Question: Briefly state, in one sentence, what is plotted here.
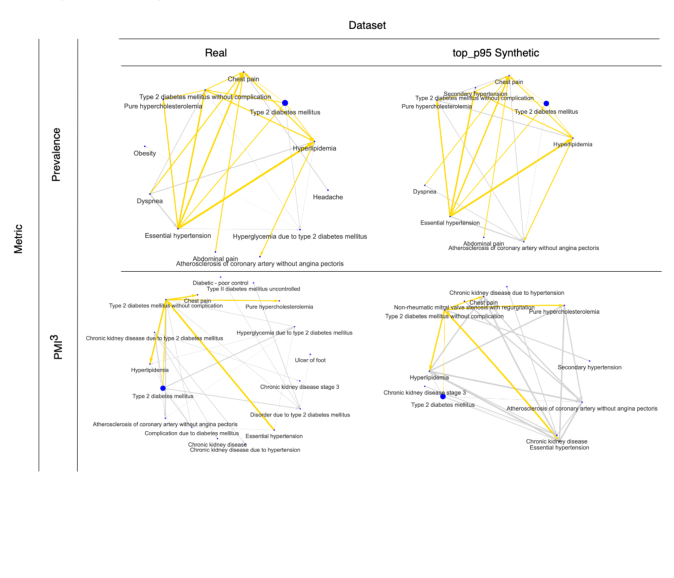
Answer: Comparison of temporal co-occurrence networks around Type 2 Diabetes Mellitus (T2DM) for real (left) and synthetic data (right). Networks were constructed with T2DM’s (large circle) top 5 co-occurring condition concepts and their own top 5 co-occurring condition concepts. The metrics Prevalence (top) and Pointwise Mutual Information-3 (PMI3) (bottom) were used to quantify co-occurrence. Gold edges indicate edges that are shared by both real and synthetic data, edge thickness indi- cates the strength of co-occurrence, and arrow direction indicates the direction of the temporal association.